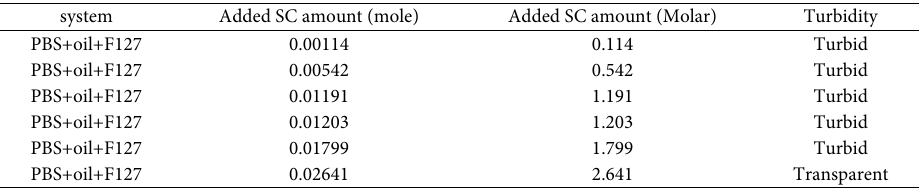
Table 1. The added co-surfactant concentration (SC) to the solution of Pluronic F127 and ethyl butyrate in PBS to find a transparence solution in the absence of drug ([F127]=0.009 M , [Ethyl butyrate]= 4.304 M) system